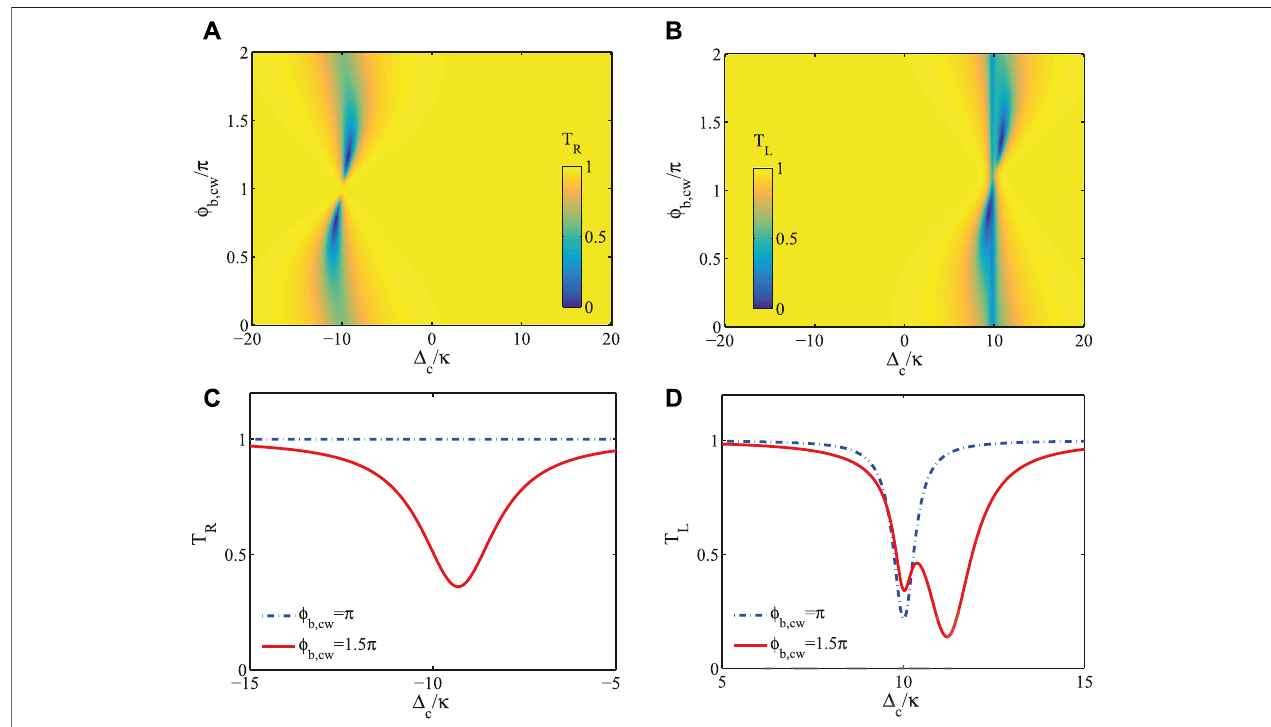
FIGURE5| (Coloronline)Transmission rates T R (A) and T L (B) versusthedetuning Δ c / κ andthephase ϕ b ,cw / π .Thecorresponding transmissionratesasafunction ofdetuning Δ c / κ fordifferentphases ϕ b ,cw / π areplottedin (C,D) .Theparametersaresetas: κ =5×10 − 3 ω c , Ω =0.97 GHz, κ i j , e (cid:1) κ , κ i =0.5 κ ,and ϕ a ,cw = ϕ L ,cw = π with i = a , b and j = 1, 2.